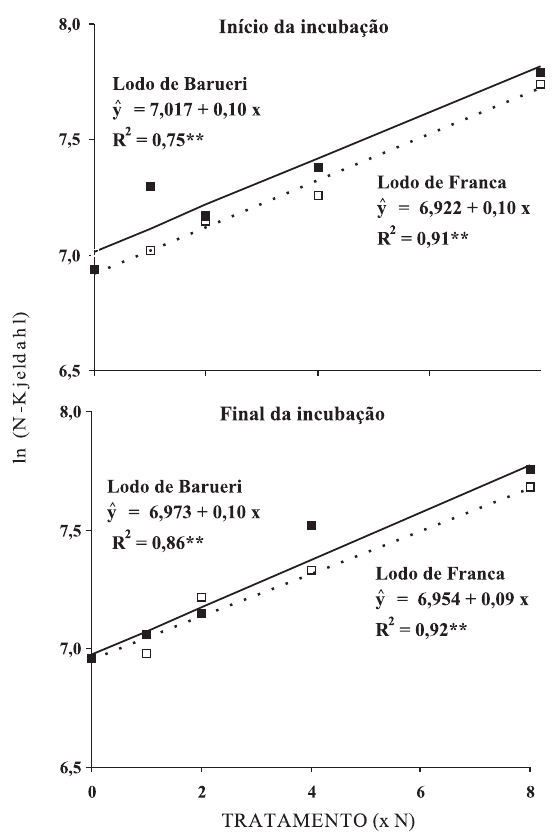
Figura 1. Logaritmo neperiano do teor de N-Kjeldahl (mg kg -1 ) no início (t = 0 dia) e no final (t = 105 dias) da incubação de Latossolo tratado com quatro aplicações de lodos de esgoto em quatro cultivos de milho. * e **: regressão linear significativa (5 %) ou muito significativa (1 %) pelo teste F. 1N: Dose de lodo calculada para adubação nitrogenada de milho (dose total aplicada: 14.716 kg ha -1 de lodo de Franca ( ) e 22.700 kg ha -1 de lodo de Barueri ( )); 0N, 2N, 4N e 8N representam múltiplos desse